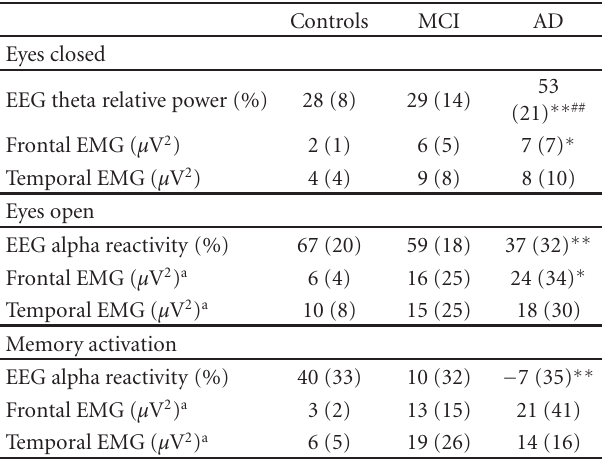
Table 2: EEG and EMG